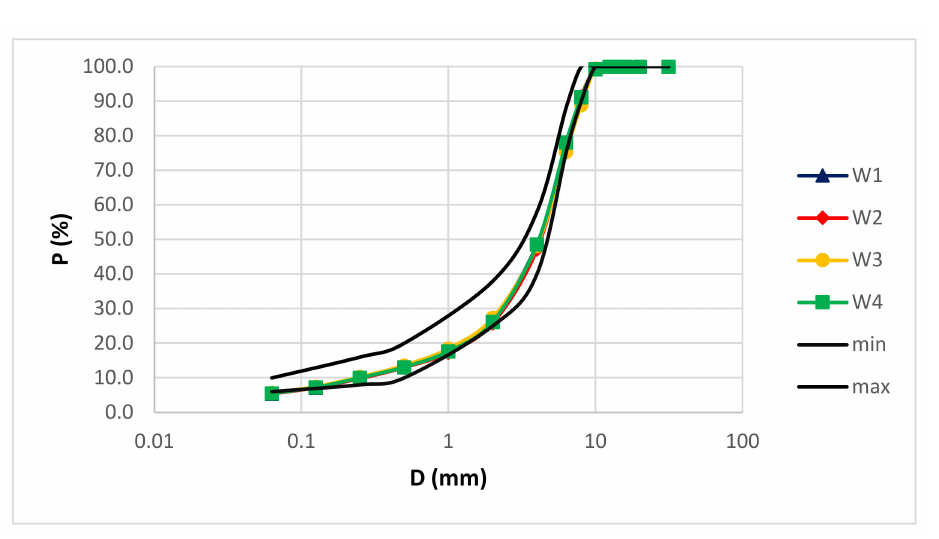
Figure 2. Aggregate grading of the wearing layers.